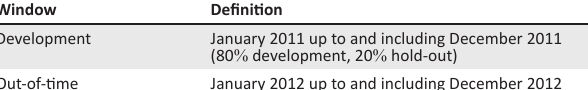
TABLE 5: Internal application scorecard build windows.